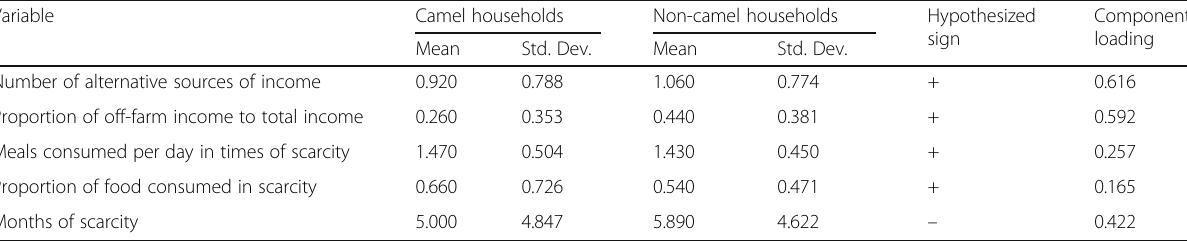
Table 4 Summary of variables used to construct a ‘ Drought Resilience Index ’ (DRI) Variable Camel